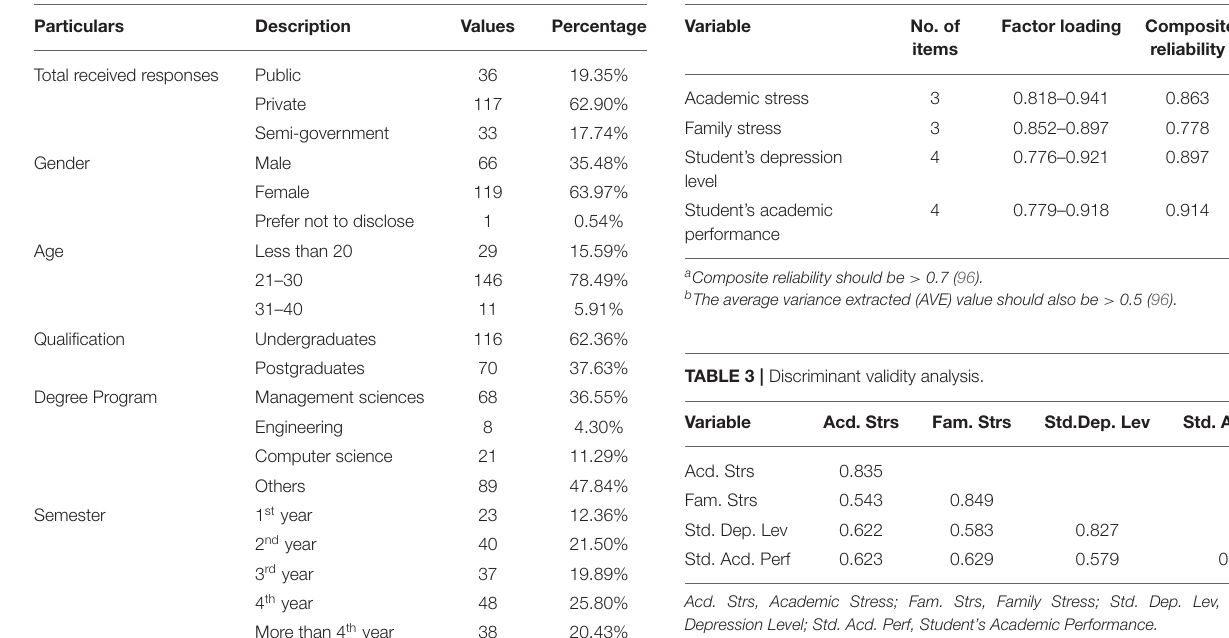
TABLE 1 | Respondent’s demographic profile. TABLE 2 | Instrument reliability and validity.